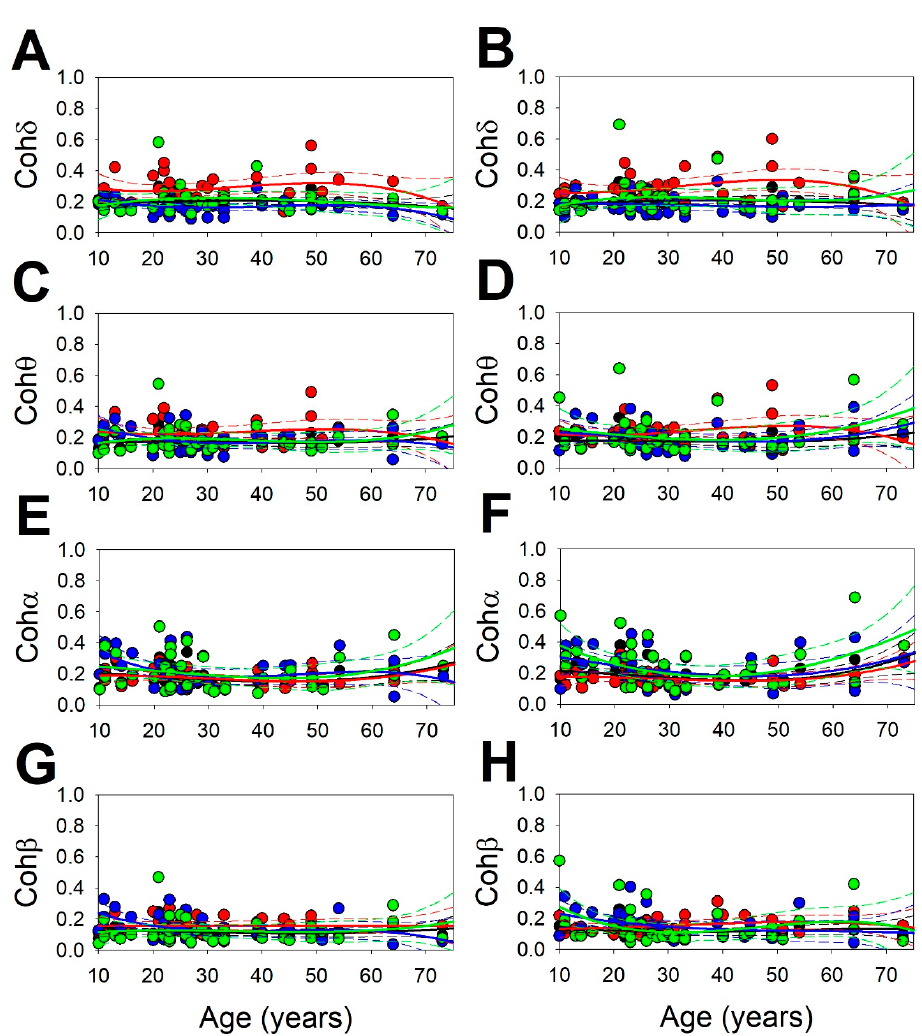
Figure 4. Scatter plot showing the values of synchronization measures as function of age. Regression lines superimposed. ( A ) Left Coh δ ; ( B ) Right Coh δ ; ( C ) Left Coh θ ; ( D ) Right Coh θ ; ( E ) Left Coh α ; ( F ) Right Coh α ; ( G ) Left Coh β ; ( H ) Right Coh β . Dots and solid lines = H; red dots and red lines = F; blue dots and blue lines = PO; green dots and green lines = T. Continuous lines = quadratic regression functions; dashed lines = 95% coefficient